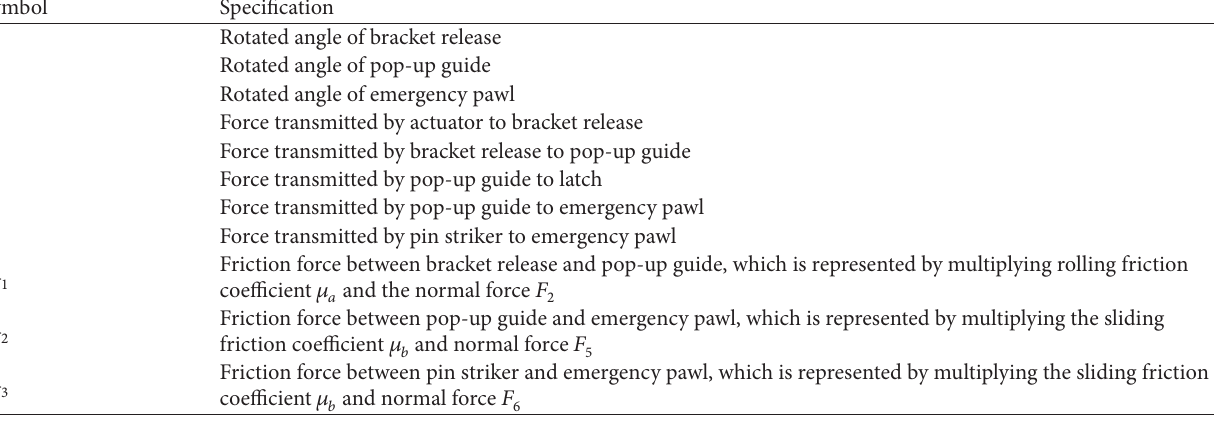
Table 3: Variables used in dynamic equation.